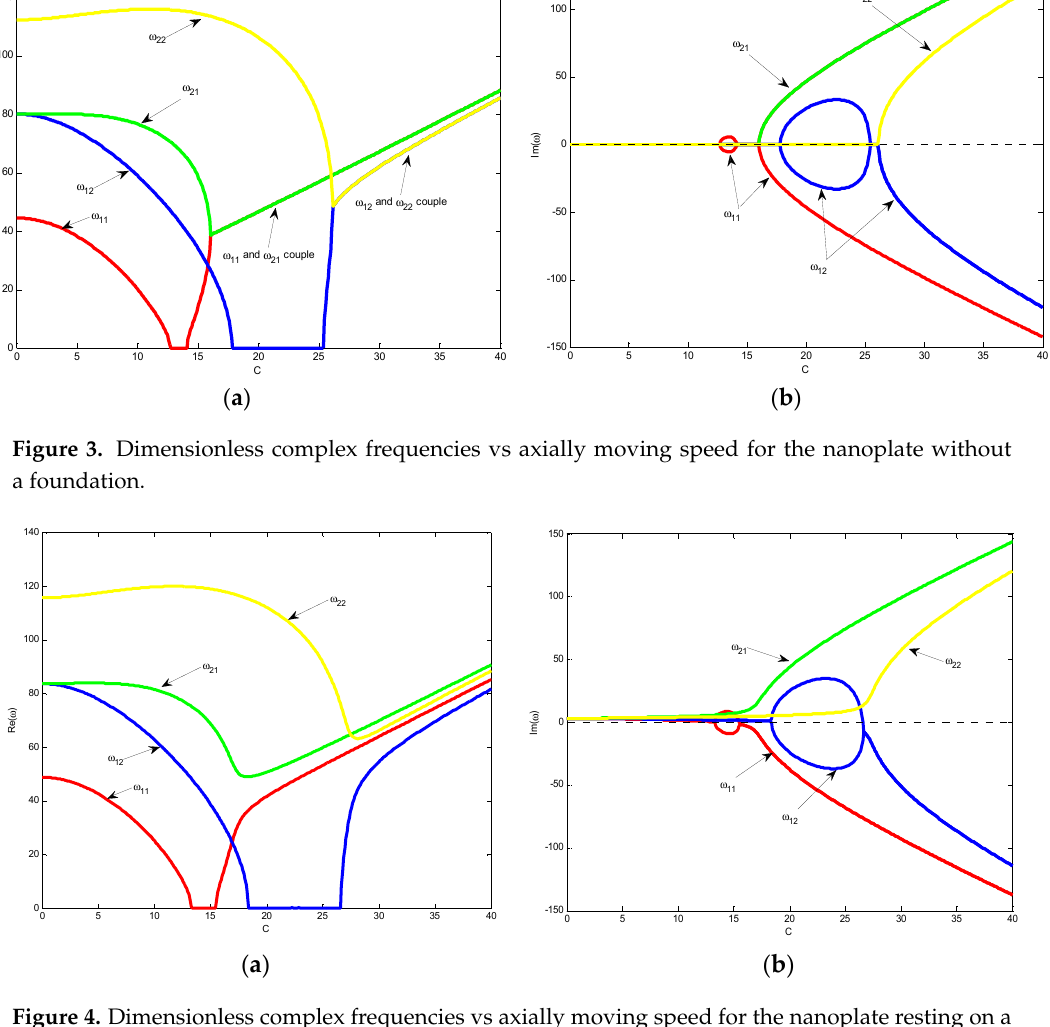
Figure 4. Dimensionless complex frequencies vs axially moving speed for the nanoplate resting on a viscoelastic foundation.